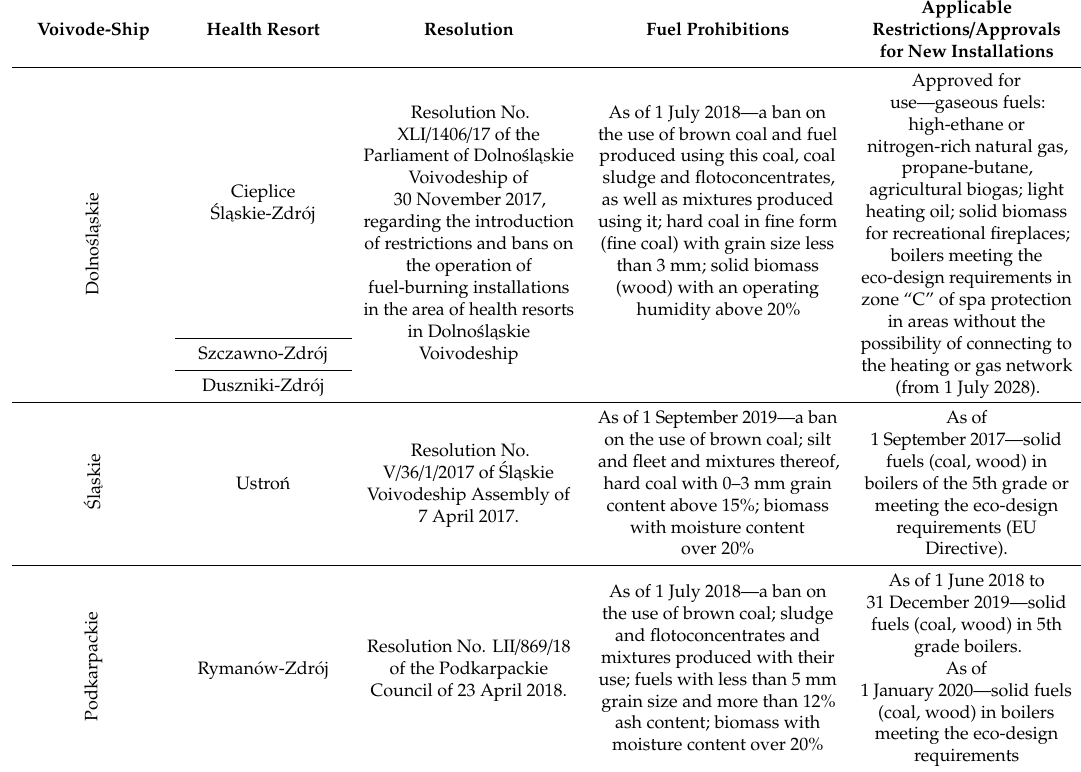
Table 8. Resolutions applicable to the analyzed health resorts regarding the introduction of restrictions and bans on the operation of fuel-burning installations (Source: own study based on